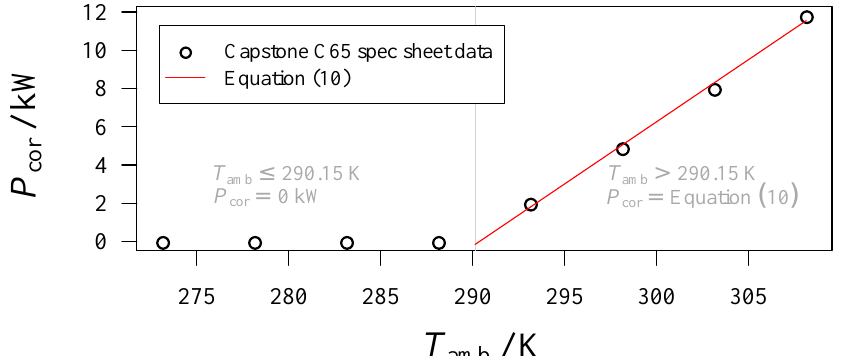
Figure 3. Power correction vs. ambient air temperature at an altitude of 157m for Capstone C65 MGT. The R 2 of the linear fit is 0.99.